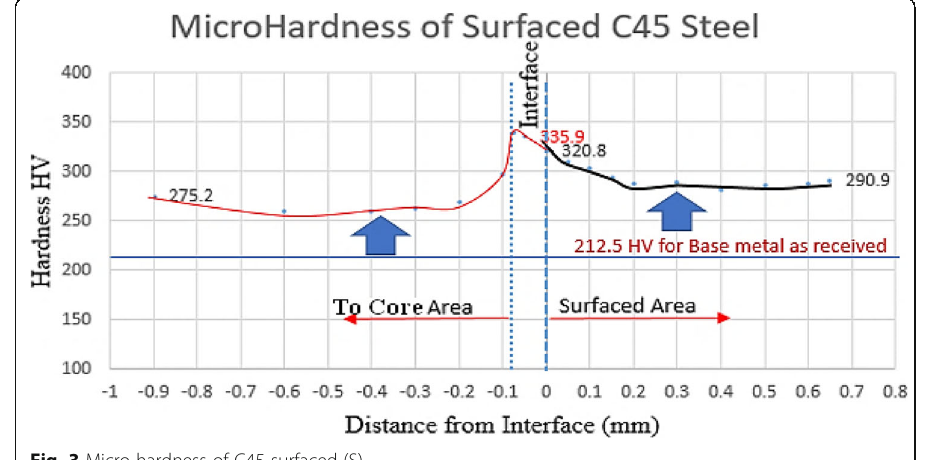
Fig. 3 Micro-hardness of C45 surfaced